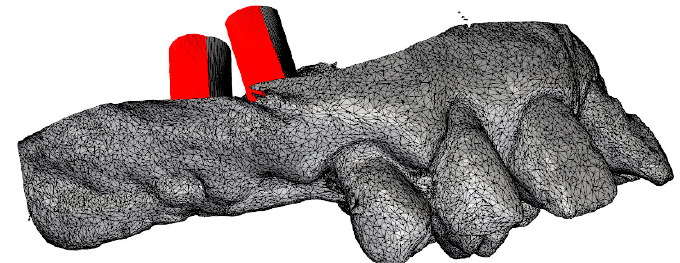
Figure 4. Superimposition of the Surface Tessellation Language (STL) derived from the planning with the STL taken after implant placement.